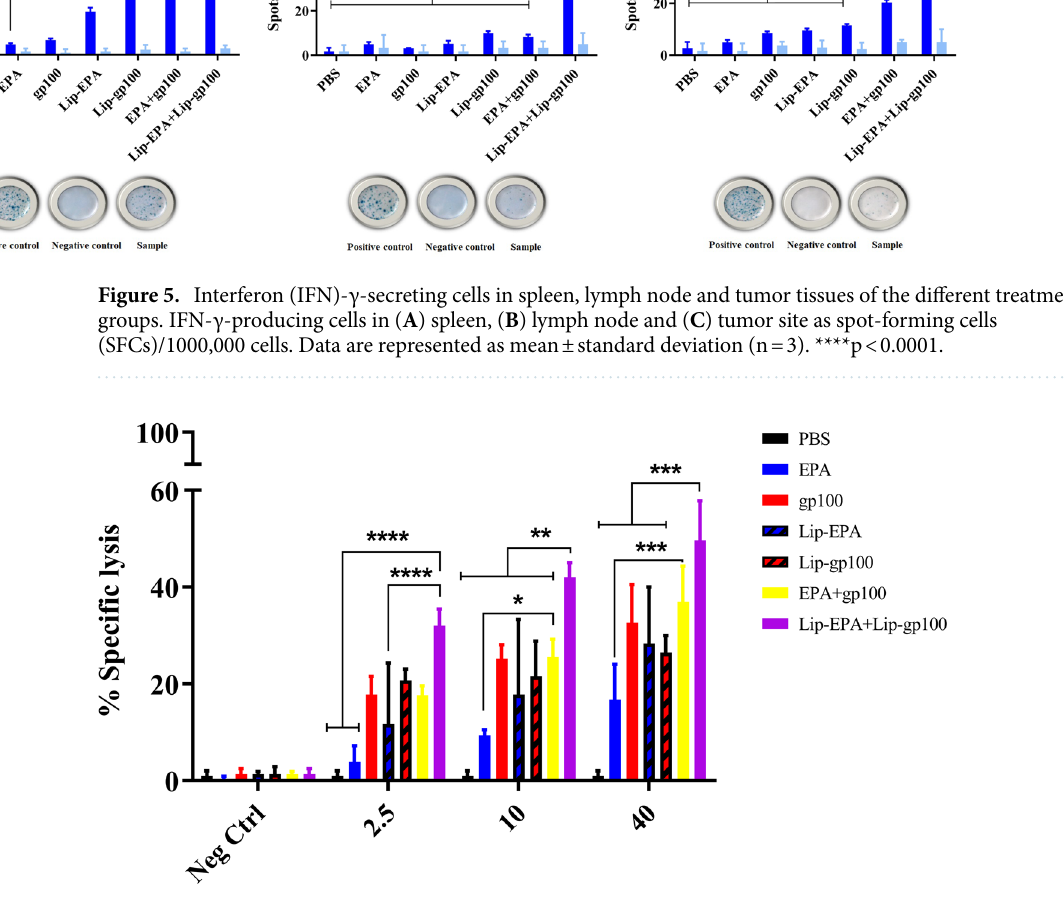
Figure 6. The cytotoxic activity of CTL cells. Antigen-specific cytotoxic activity of CTLs was assessed using different ratios of effector (splenocytes) to target (Calcein AM-labelled B16F10 cells expressing gp100 antigen) cells (E/T). Calcein AM-labelled CT26 cell line was used as negative control. Data are represented as mean ± standard deviation (n = 3). *p < 0.05, **p < 0.01, ***p < 0.001, ****p <